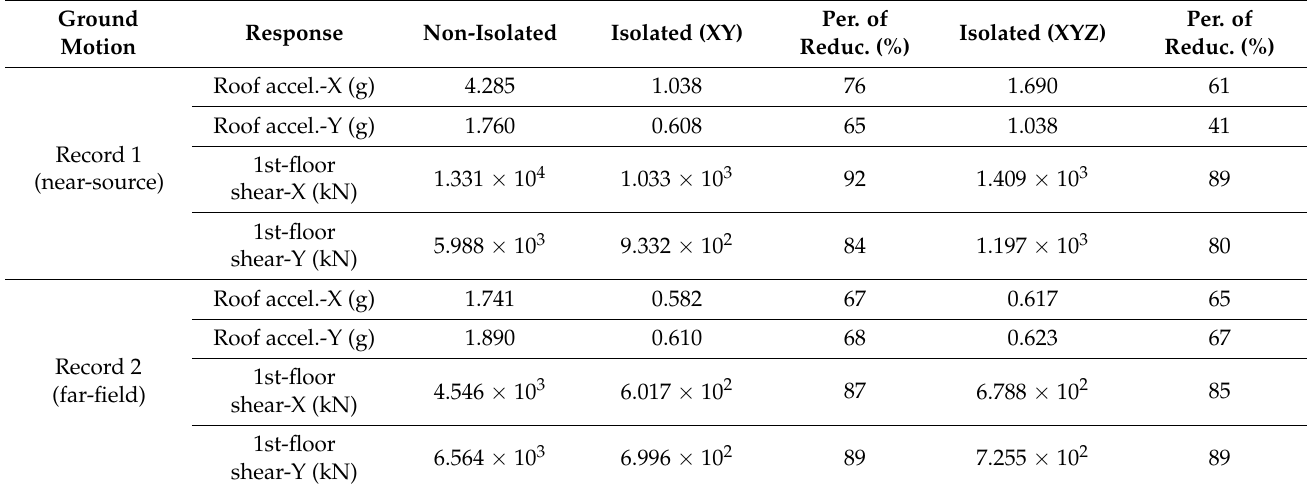
Figure 9 . Hysteresis loops under bi- and tri-directional excitations: ( a , b ) X- and Y-response of the near-source earthquake and ( c , d ) X- and Y-response of the far-field earthquake.